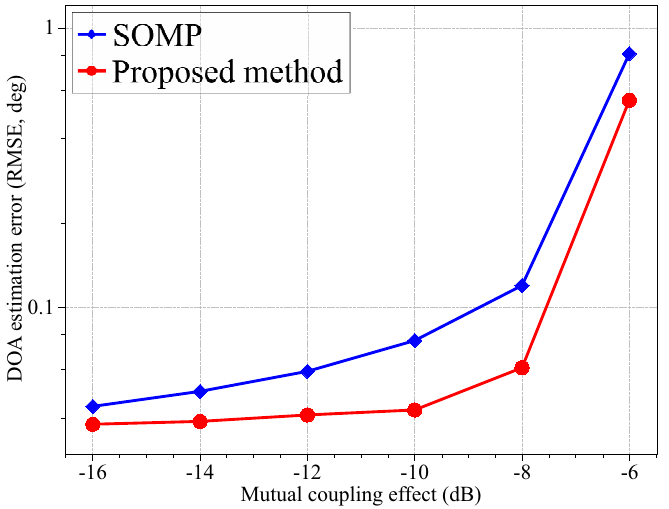
Figure 4. DOA estimation performance with different MC effect.